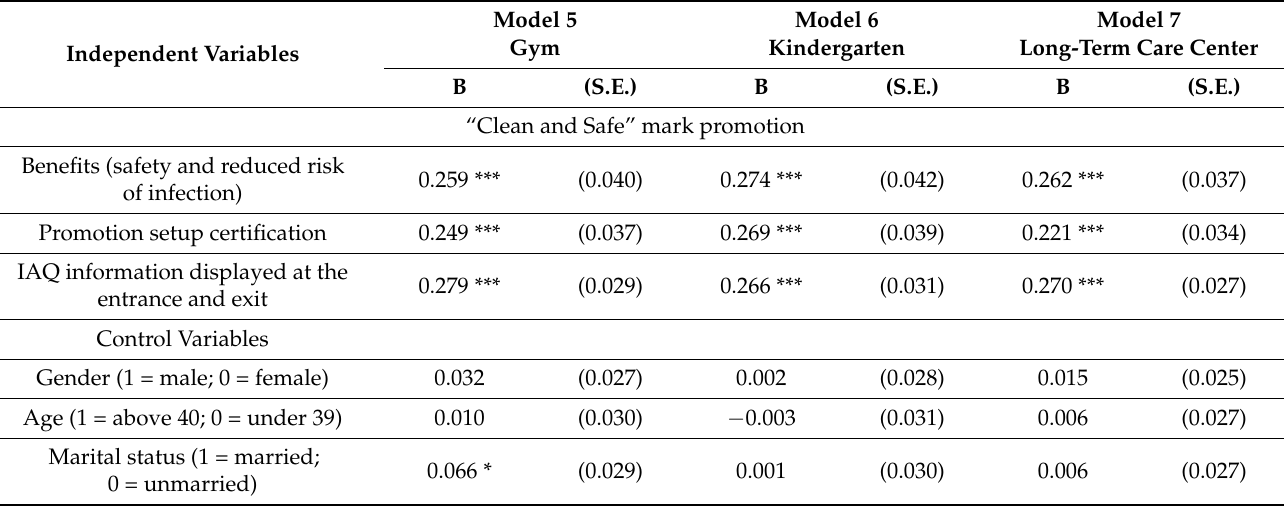
Table 11. The “Clean and Safe” mark promotion regression (three